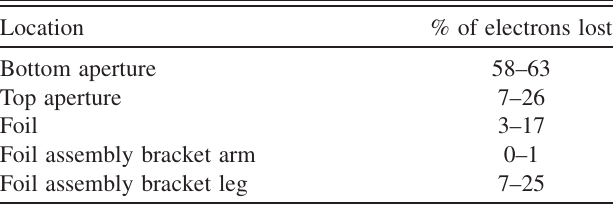
TABLE III. Loss distribution of electrons for 3rd generation foil assembly.